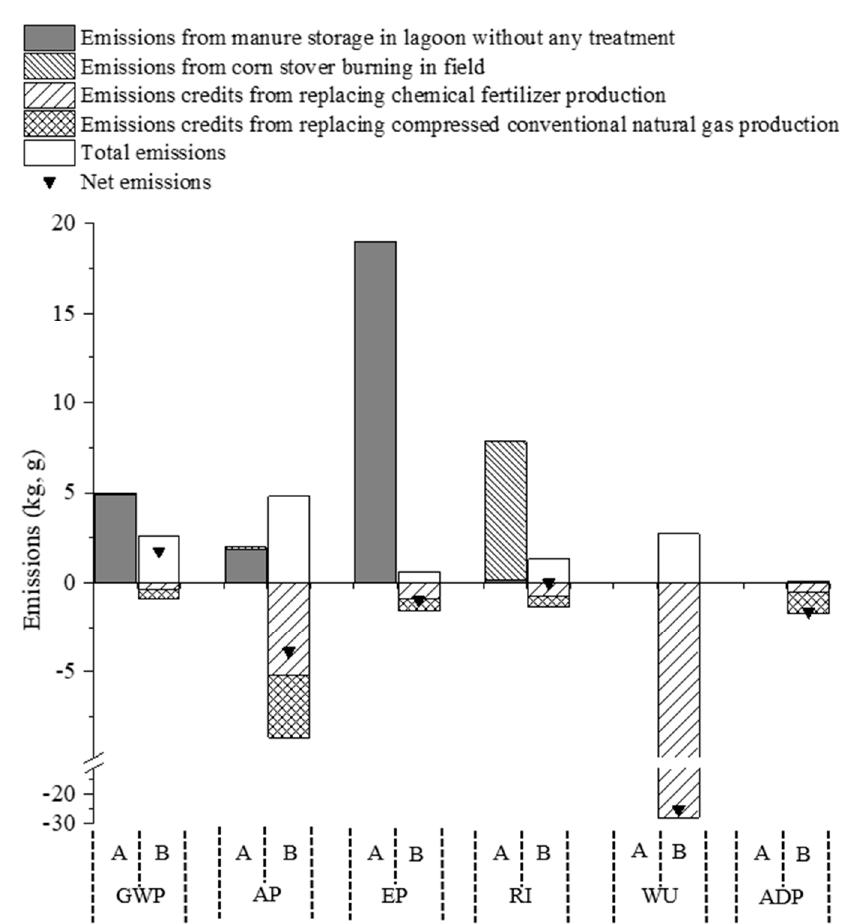
Figure 2. Environmental impacts of the system with emission credits for 1 m 3 CBG production. GWP: global warming potential, kg CO 2 -eq; AP: acidification potential, g SO 2 -eq; EP: eutrophication potential, g PO 43 − -eq; RI: respiratory inorganics, g PM 2.5 -eq; WU: water use, kg; ADP: abiotic depletion potential, 10 − 4 g Sb-eq. (A, Reference case; B, manure co-digestion with corn stover for large-scale compressed bio-natural gas production.).